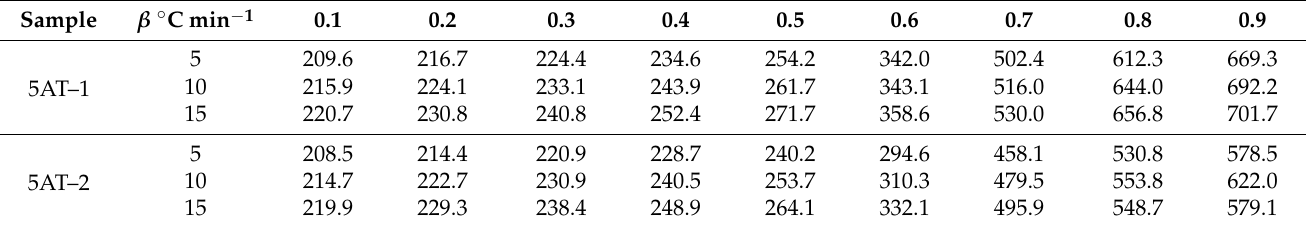
Figure 3. The TG-DTG curves of 5AT–2 at 10 °C min − 1 . Table 2. Characteristic temperatures at different conversions of mass-loss